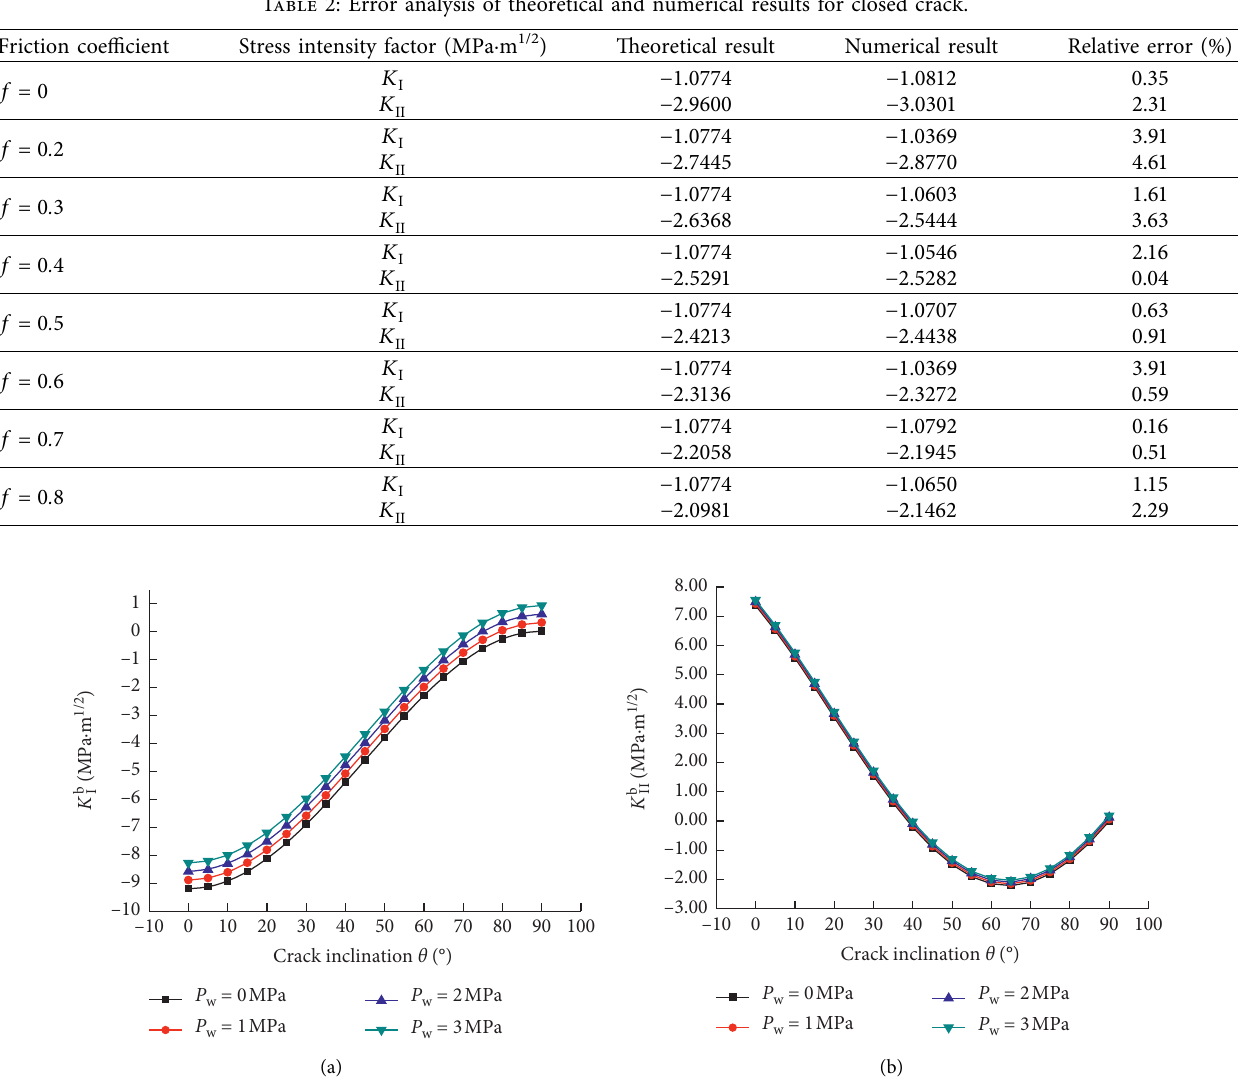
Figure 5: Relationship between crack inclination and stress intensity factor of closed cracks with different pore pressures ( f � 0.8, σ x � 0MPa). (a) Mode I. (b) Mode